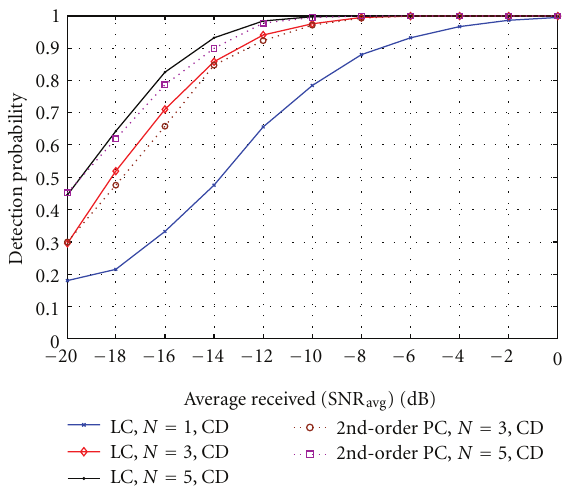
Figure 10: Detection performance for cooperative LC and PC with coherent-based feature extraction: P f = 10% and preamble length L = 16bits.